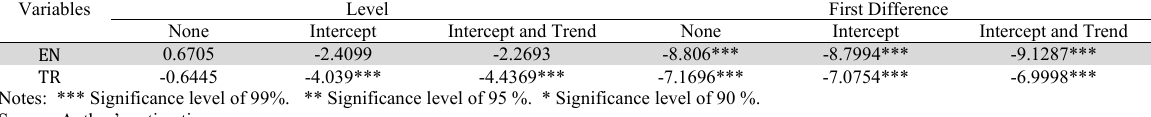
Stationarity test by the Augmented Dickey-Fuller test.